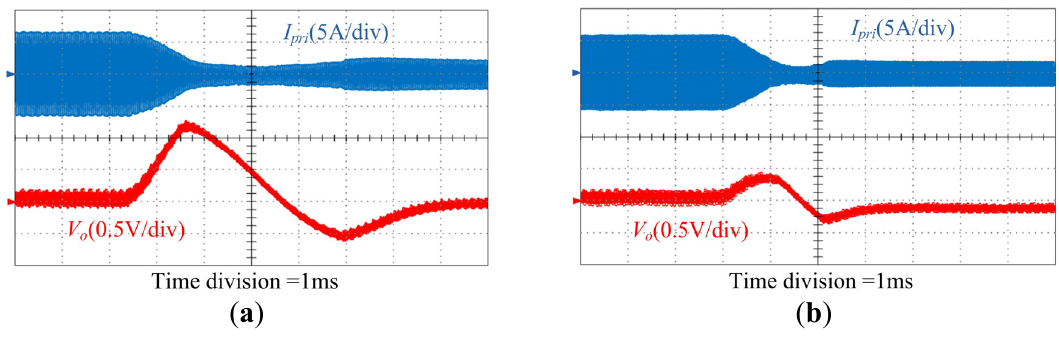
Figure 28. Dynamic responses of the converter for load step transient (20 A–4 A). ( a ) Using conventional PI controller; ( b ) Using adaptive PI controller.